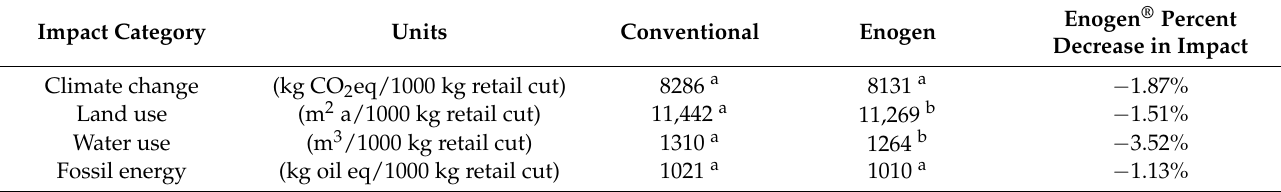
Table 6. Environmental impacts and improvements for Scenario 5, full BG plus full FY. Animals simulated for both feed treatments to reach the same background and finish weights; FY gain from 380 to 662